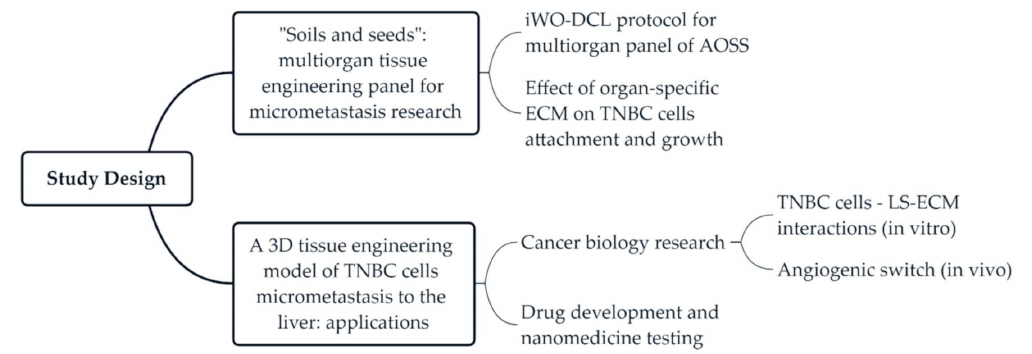
Figure 1. The design of the current study. Abbreviations: iWO-DCL—immersion whole-organ decellularization; AOSS— acellular organ-specific scaffolds; ECM—extracellular matrix; TNBC—triple-negative breast cancer; 3D, three-dimensional; LS-ECM—liver-specific